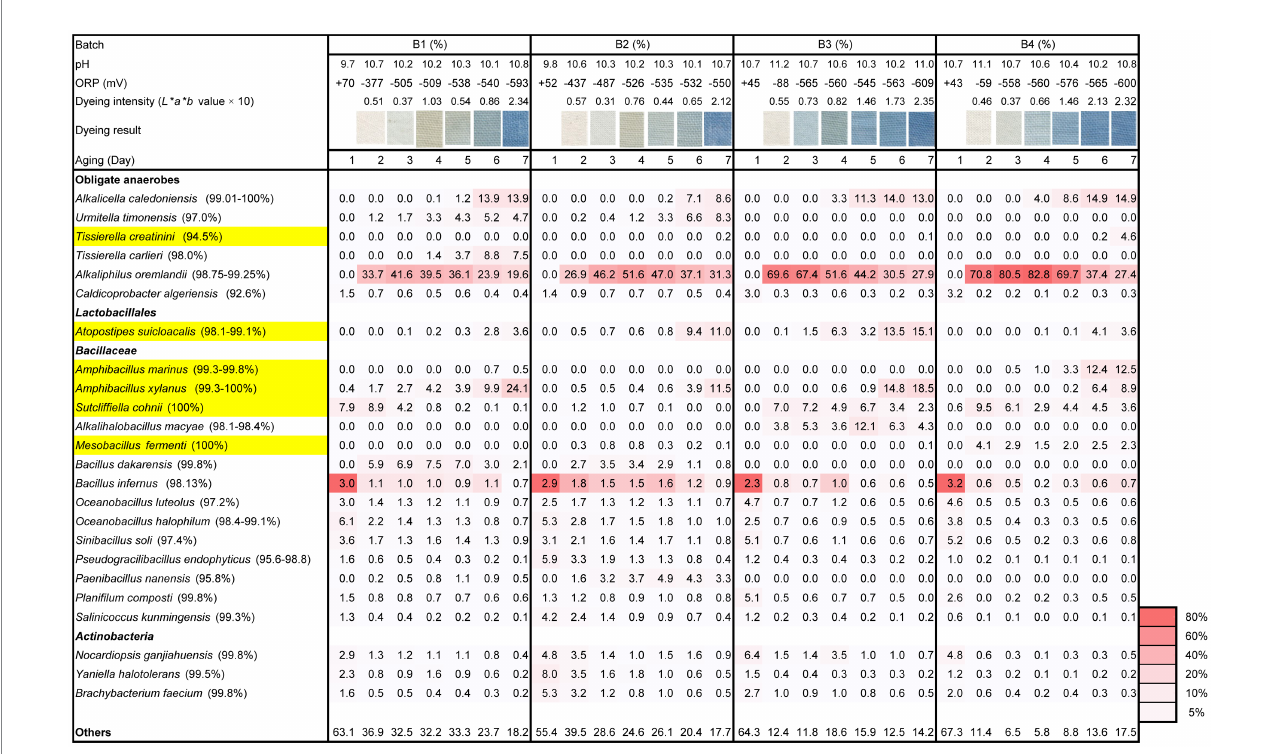
FIGURE 1 Changes in the relative abundance (%) of bacterial communities ( ≥ 4.1% in any sample) based on 16S rRNA analysis, dyeing intensity (dyeing result and L * a * b * value), ORP, and pH during days 1–7 following different initial treatments of sukumo . B1: batch 1 ( sukumo treated with 60 ° C tap water); B2: batch 2 ( sukumo treated with 25 ° C tap water [control]); B3: batch 3 ( sukumo treated with 25 ° C wood ash extract); B4: batch 4 (control; sukumo treated with 60 ° C wood ash extract). Yellow marked taxa indicate the confirmed indigo-reducing taxa (including unpublished results). The percentages in the brackets indicate the similarities with the top hit taxa as revealed via a BLAST (blastn) search in